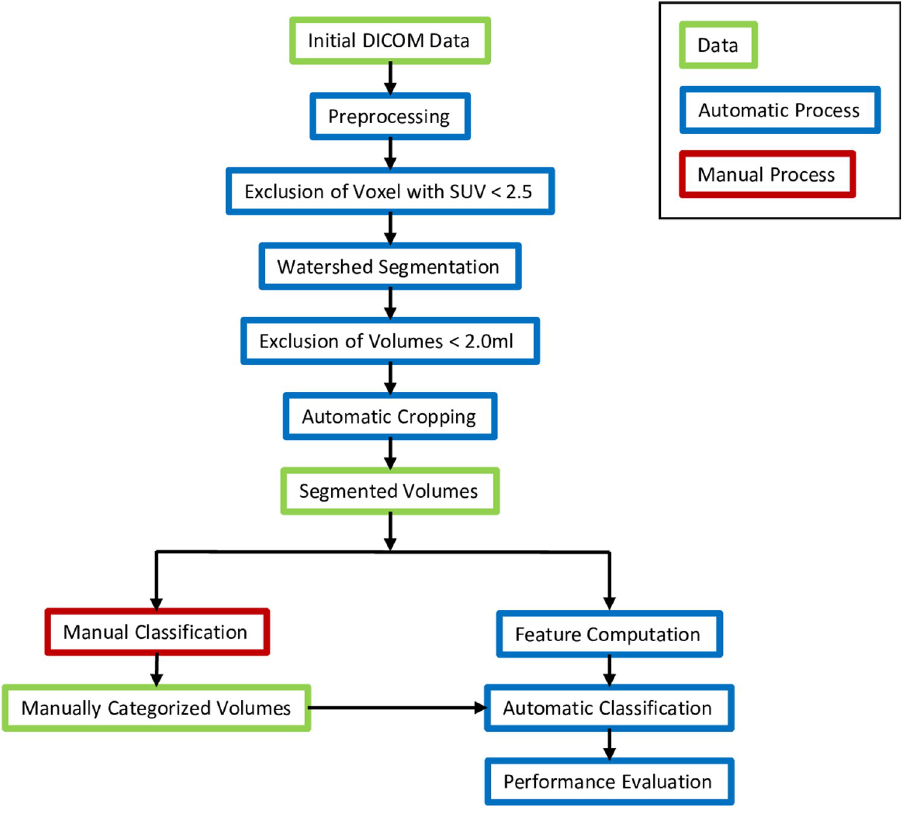
Fig 1. Methodical workflow of the classification